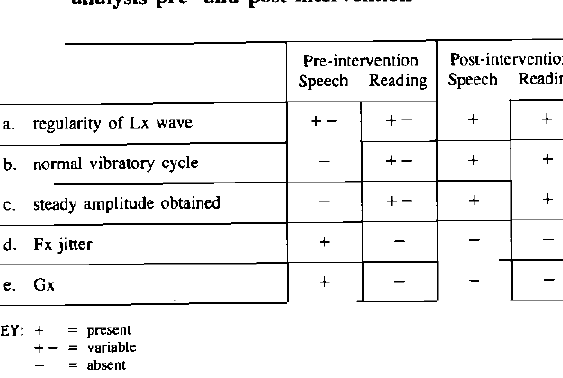
Table 1 Summary of overall trends of laryngographic analysis pre- and